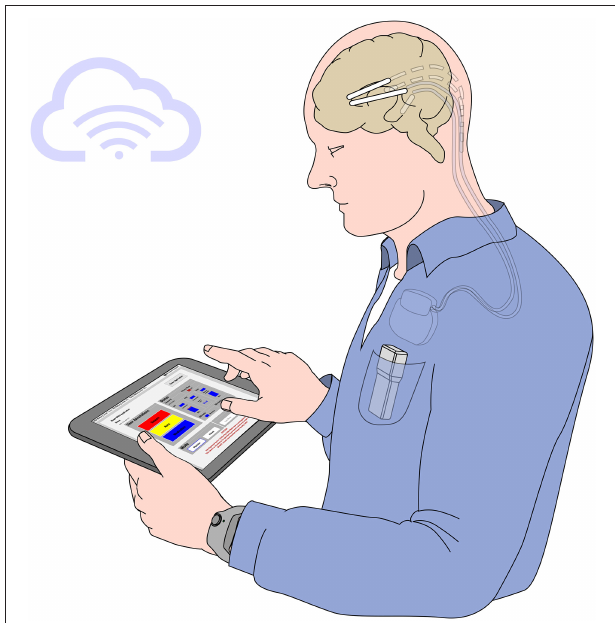
FIGURE 1 | The EPAD system—The EPAD system user interface and core logic deployed along with on-tablet seizure detection and forecasting algorithms. EEG data packets from the investigational Medtronic Summit RC + S TM implanted device are decoded, sorted, assembled, compressed, and stored in a cloud-synchronized repository in Multiscale Electrophysiology Format (MEF v.3.0). In addition, dense behavioral inputs from the patient interaction with the EPAD system and data from external wearable devices are synchronized over Wi-Fi or cellular data networks to a cloud-synchronized